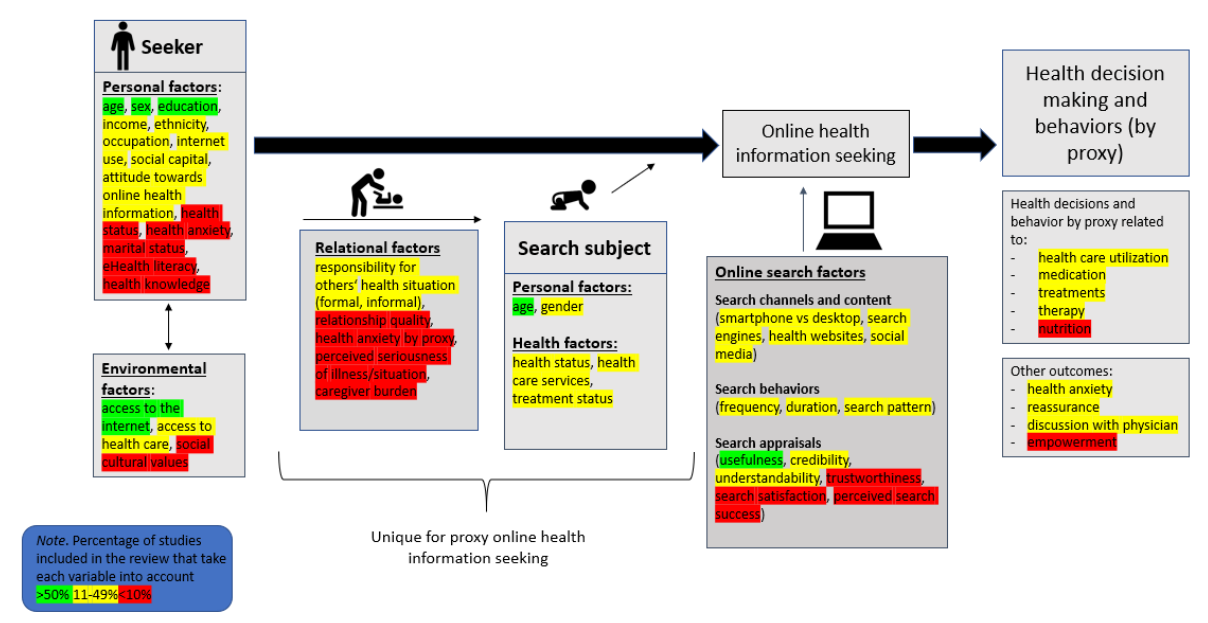
Figure 2. Model of proxy online health information seeking and decision